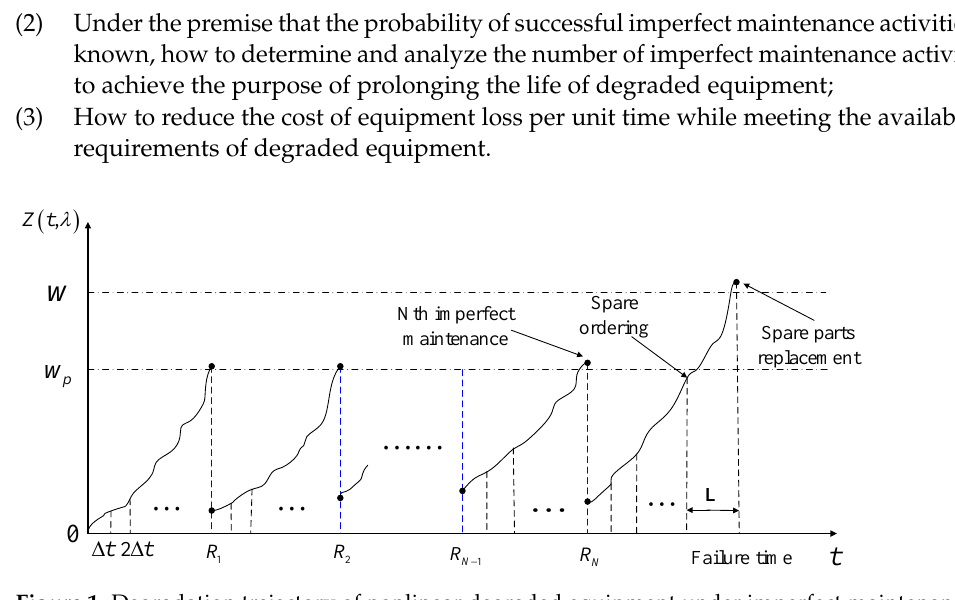
Figure 1. Degradation trajectory of nonlinear degraded equipment under imperfect maintenance.